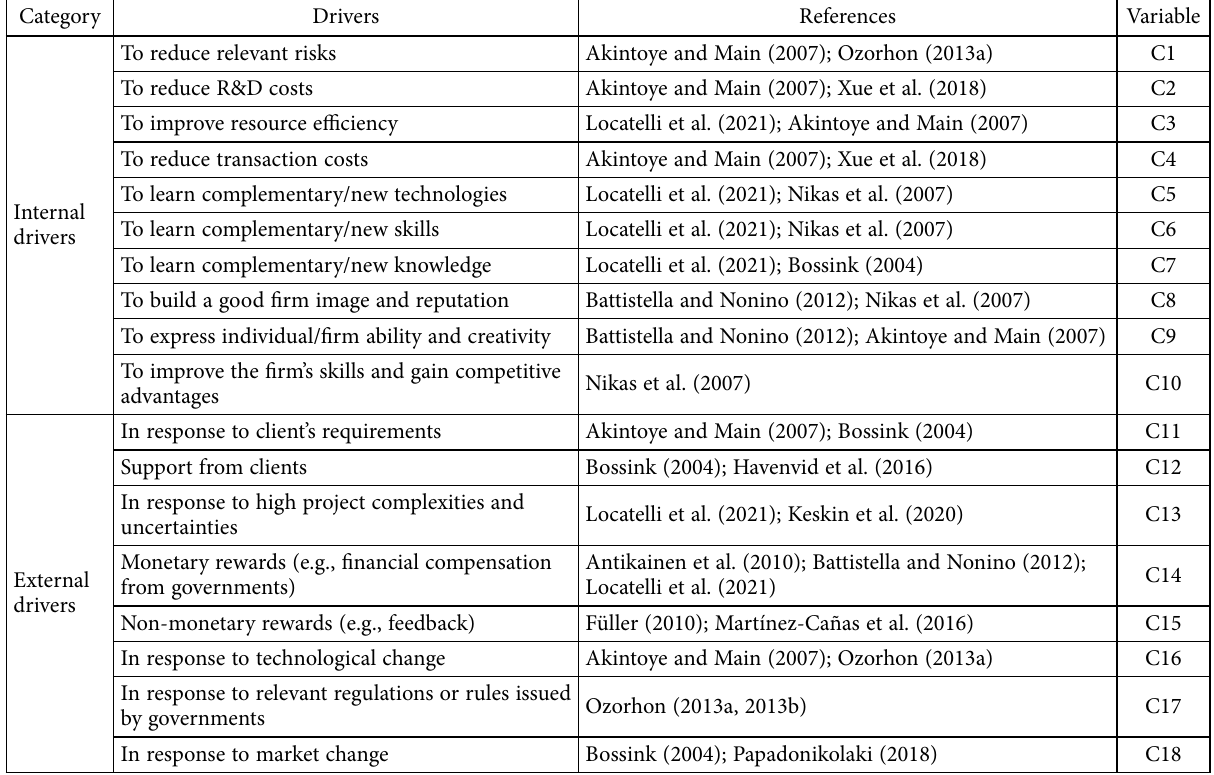
Table 1. Drivers of collaborative innovation among